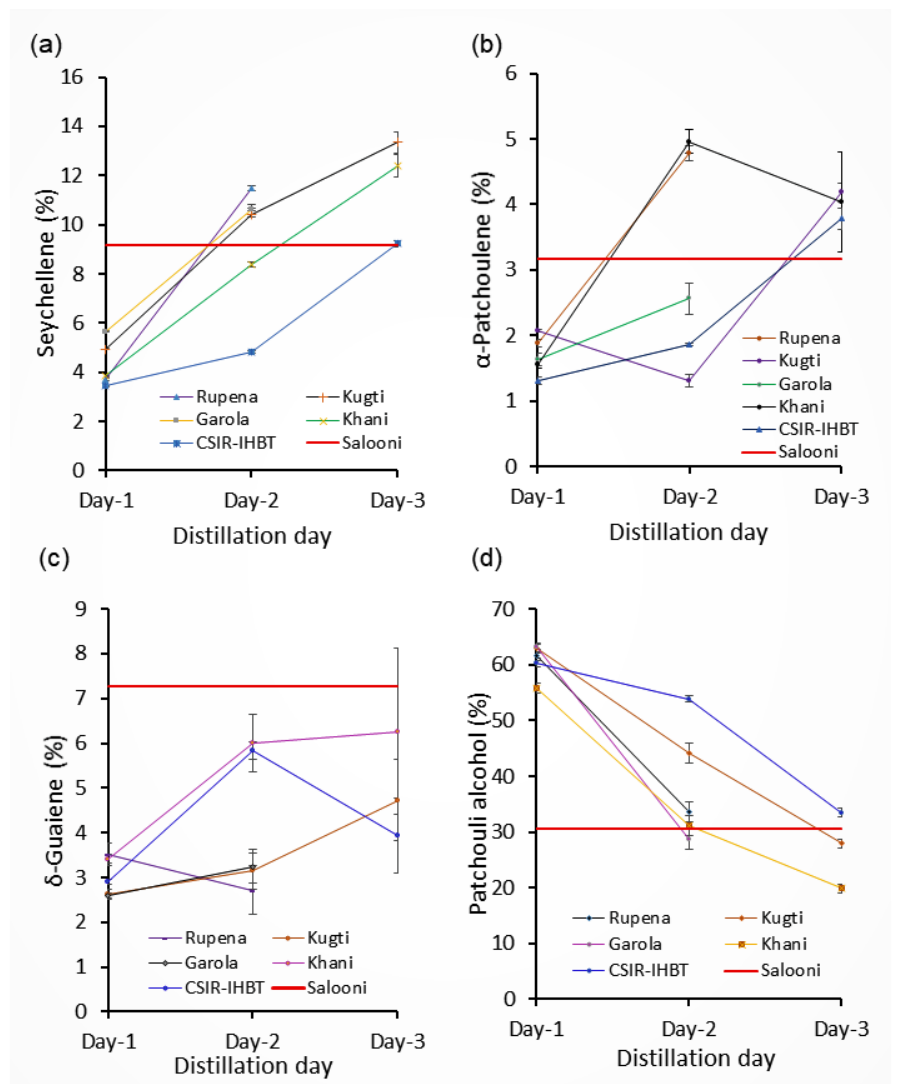
Figure 4. The dynamic of patchouli alcohol ( a ), seychellene ( b ), δ -guaiene ( c ), and α -patchoulene ( d ), under repetitive distillation method for the different populations.